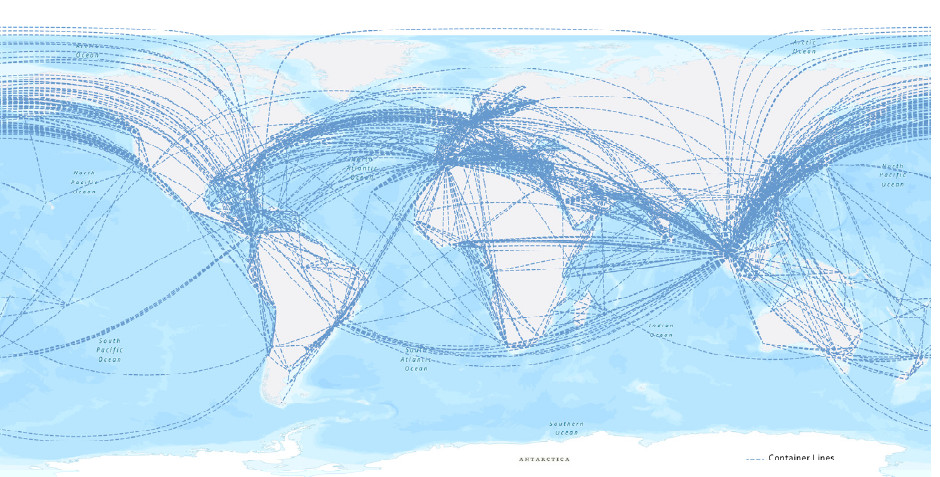
Figure 1. Route linkages (not actual routes) of the 6 liner shipping operators showing interconnections between ports (nodes). We added the attribute of transit time to the linkages so that linkages could reflect the route of real maritime transport.